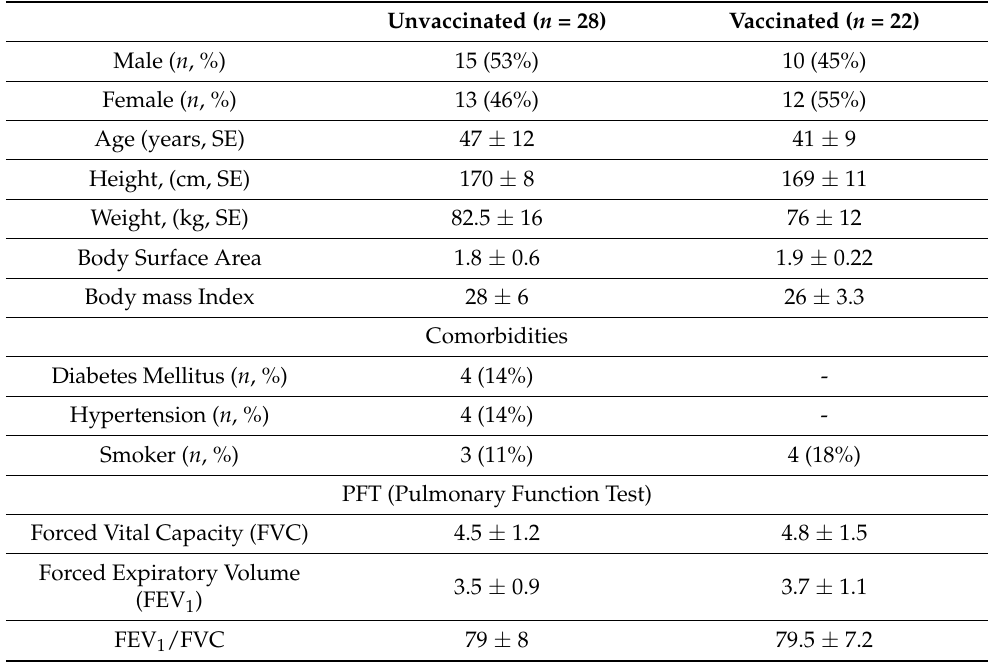
Table 1. Participant characteristics, symptoms and pulmonary function test (PFT). Unvaccinated ( n = 28) Vaccinated ( n = 22) Male ( n , %) 15